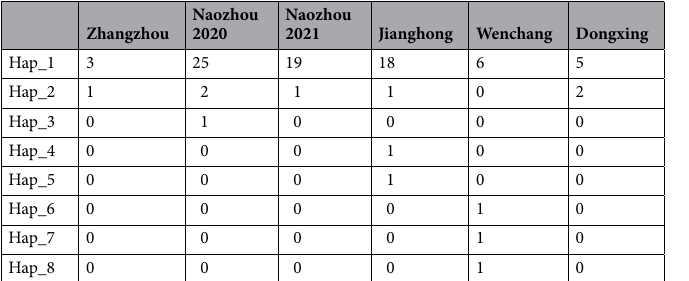
between sampling groups were from −0.2404 to 0.1477, and all the pairwise FST between sampling groups were not statistically significant. Temporally resolved elemental ratios. The MRT models based on the scaled Ba:Ca and Sr:Ca ratios detected the different numbers of splits. The number of segments identified from E. tetradactylum otolith Ba:Ca and Sr:Ca profiles ranged from 2 to 12, depending on individuals (on average 5.92 ± 2.29 segments). The hierar- chical clustering based on the averaged Sr:Ca and Ba:Ca of each segments identified 2 chemically distinct clusters (Fig. 5A). Based on the previous study, these clusters correspond to two types of habitat environment. Segment cluster 1 featured intermediate Ba:Ca ratios (0.0098 < Ba:Ca < 0.0496 mmol/mol) and intermediate Sr:Ca ratios (2.53 < Sr:Ca < 3.47 mmol/mol), hereafter assigned to the ‘estuarine habitat’. The other cluster featured low Ba:Ca ratios (0.0018 < Ba:Ca < 0.0110 mmol/mol) with their widely distributed Sr:Ca ratios (2.51 < Sr:Ca < 3.83 mmol/ mol), hereafter assigned to the ‘coastal habitat’. Along each transect on the otoliths, the assigned segments clus-